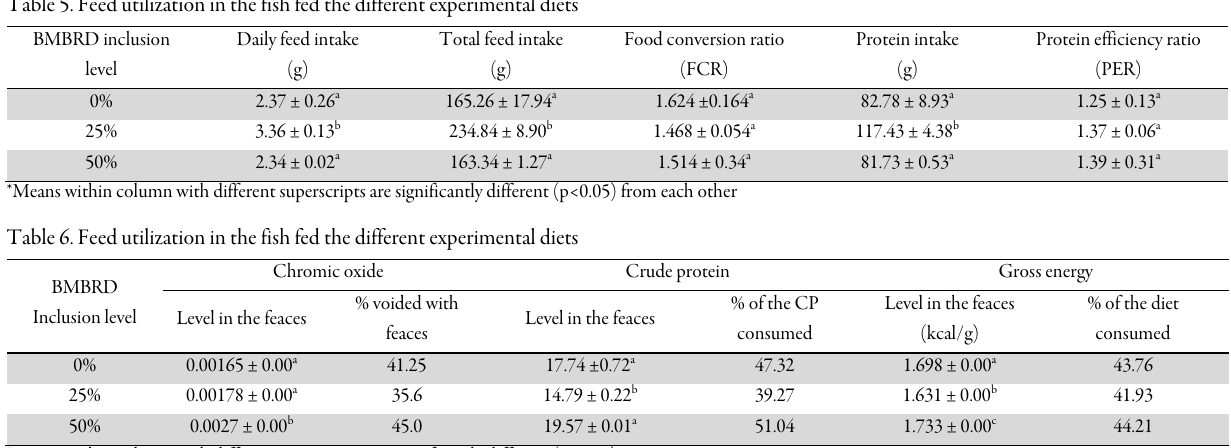
Table 5. Feed utilization in the fish fed the different experimental diets BMBRD inclusion level